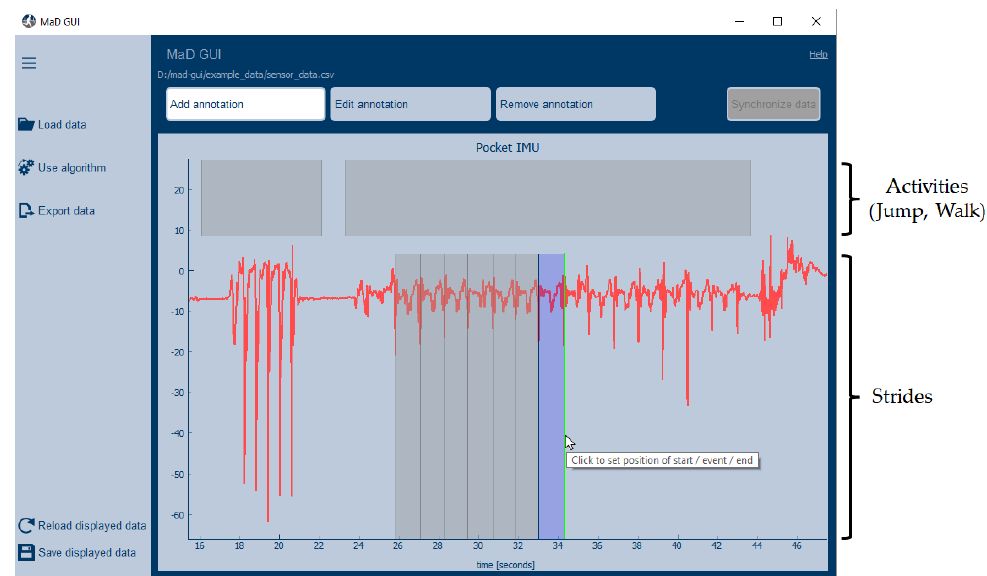
Figure 1. Main window of MaD GUI. The side-bar (left) gives access to plugins, which can be injected into the GUI. The buttons on the top change the GUI’s mode, and the Add annotation mode is selected. In the upper part of the plot (first level), activities were annotated. The second level was used to annotate strides.